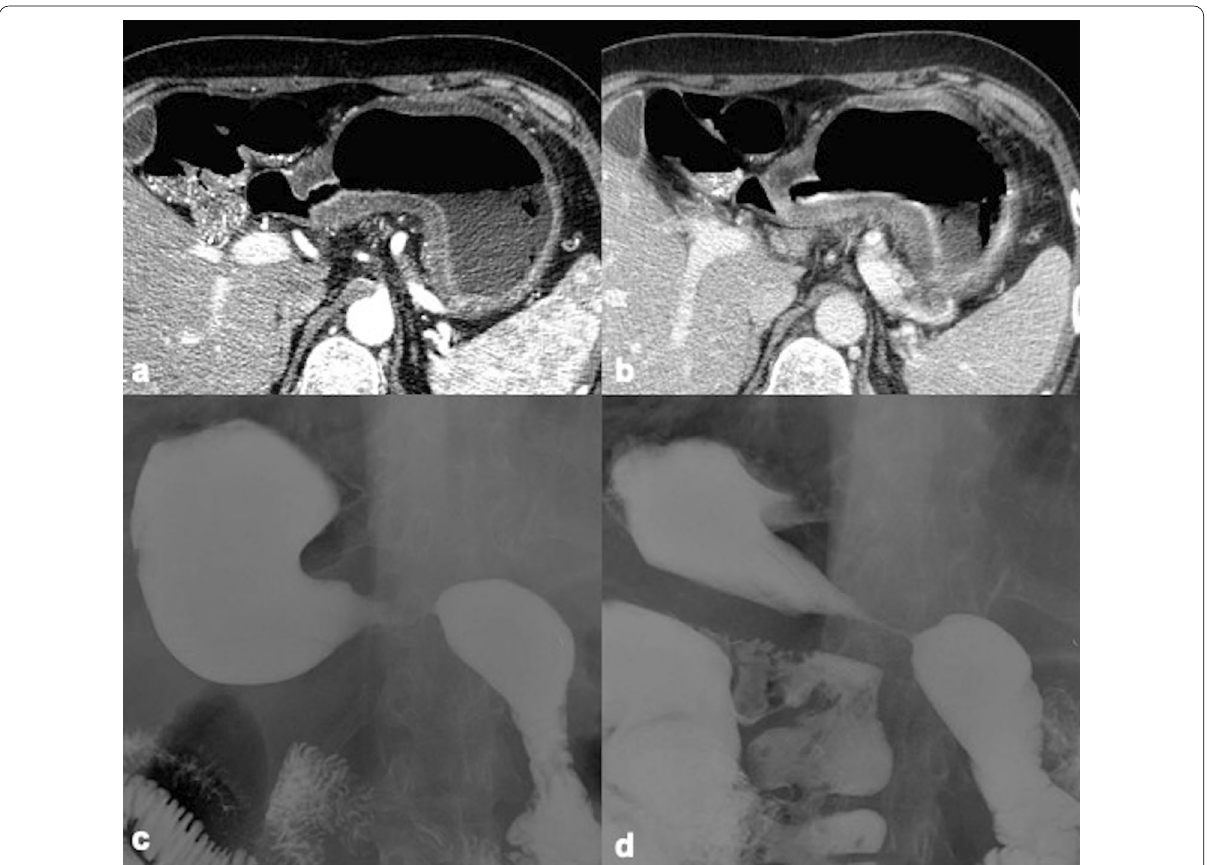
Fig. 20 Gastritis due to checkpoint inhibitor therapy (Nivolumab). CT scans in arterial ( a ) and venous ( b ) phase showing linear enhancement of the gastric mucosa and diffuse, marked edematous thickening of the submucosal layer, more evident in the prepiloric area with concentric stenosis of the antral lumen. Moderate perigastric fat stranding is appreciable. The stenotic visceral segment is confirmed at barium fluoroscopy ( c , d ), however the passage of the contrast medium at the level of duodenum and small intestine is